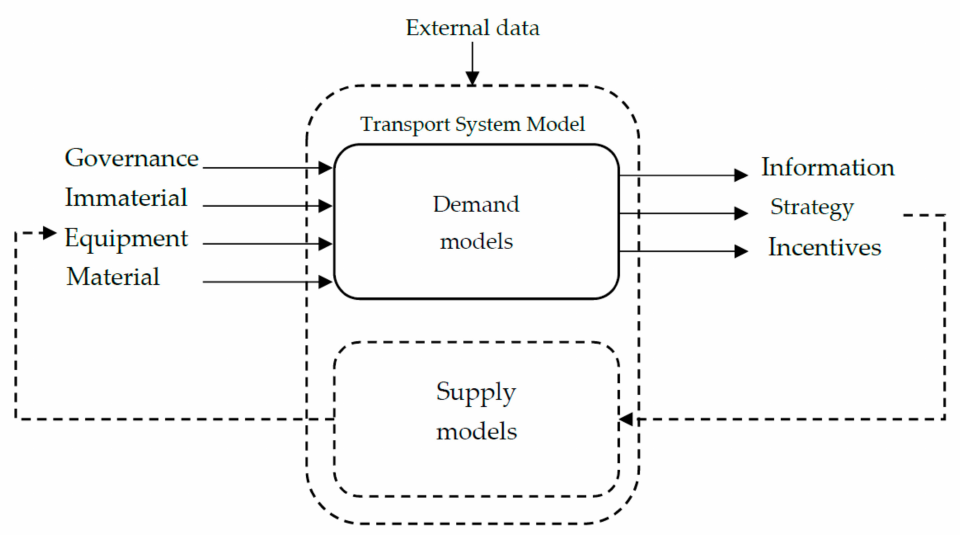
Figure 3. Inputs-outputs of demand models (and dually of supply models) inside the